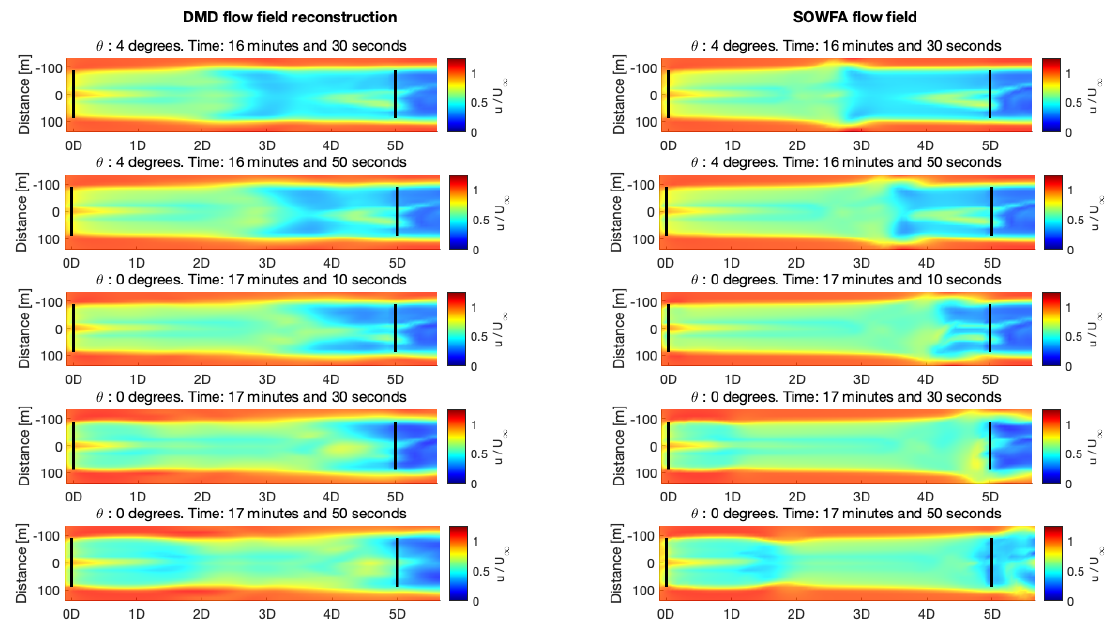
Figure 4. Comparison of flow field reconstruction using reduced linear model ( left ) and data from SOWFA ( right ) at hub height for different time instants. Reconstruction obtained using validation data